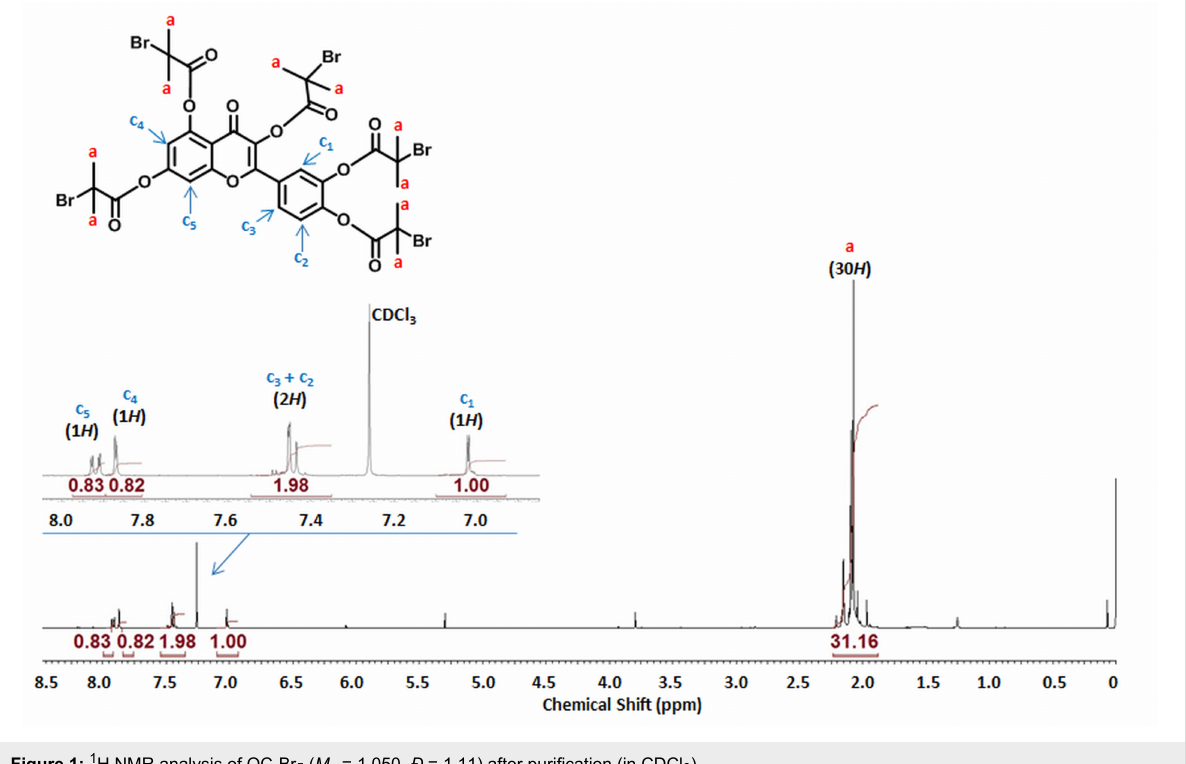
Figure 1: 1 H NMR analysis of QC-Br 5 ( M n = 1,050, Ð = 1.11) after purification (in CDCl 3